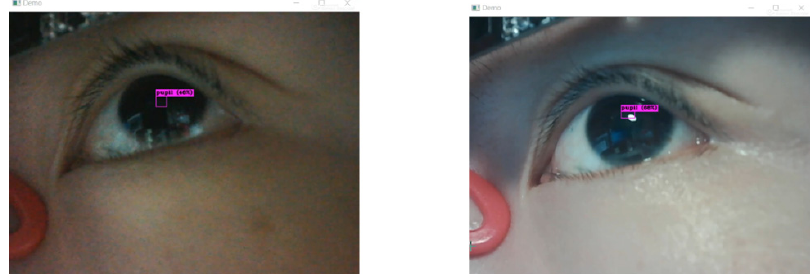
Figure 14. The inference results by using the YOLOv3-tiny-based model. For the tested eye images, to evaluate the accuracy of the trained YOLOv3-tiny-based models, Table 4 lists the comparison results of visible-light pupils’ center tracking errors between the YOLOv3-tiny and the previous designs without using deep-learning technol- ogies. In Table 4, the applied YOLOv3-tiny-based design performs smaller pupil tracking errors than the previous designs in [15,21]. The average pupil tracking error of the pro- posed deep-learning-based model is less than 2 pixels, which is much smaller than the pupil tracking error of the previous ellipse fitting design in [15]. Compared with the pre- vious design in [15,21], without using deep-learning technology, the proposed deep-learn- ing-based design has very small pupil tracking errors under various visible-light condi- tions. Table 3. Performance comparisons of visible-light pupil object detection among the three YOLO- based models.